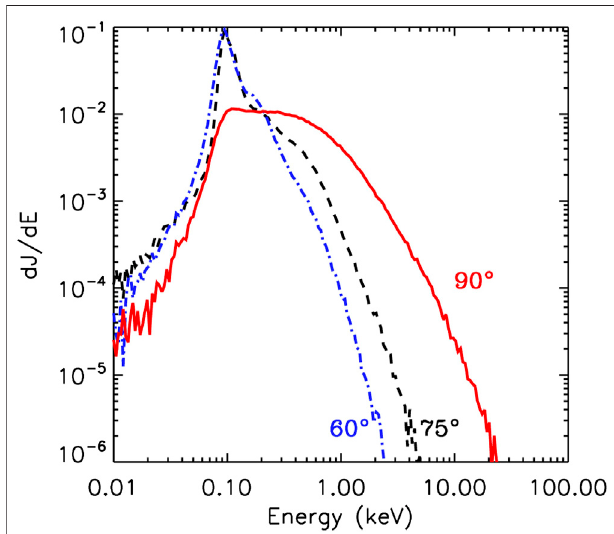
FIGURE5| Energy fl uxspectraofelectronsfordifferentaveragedshock normal angles. Results of hybrid simulations with test-particle electrons adapted from Guo and Giacalone (2010). Reproduced by permission of the